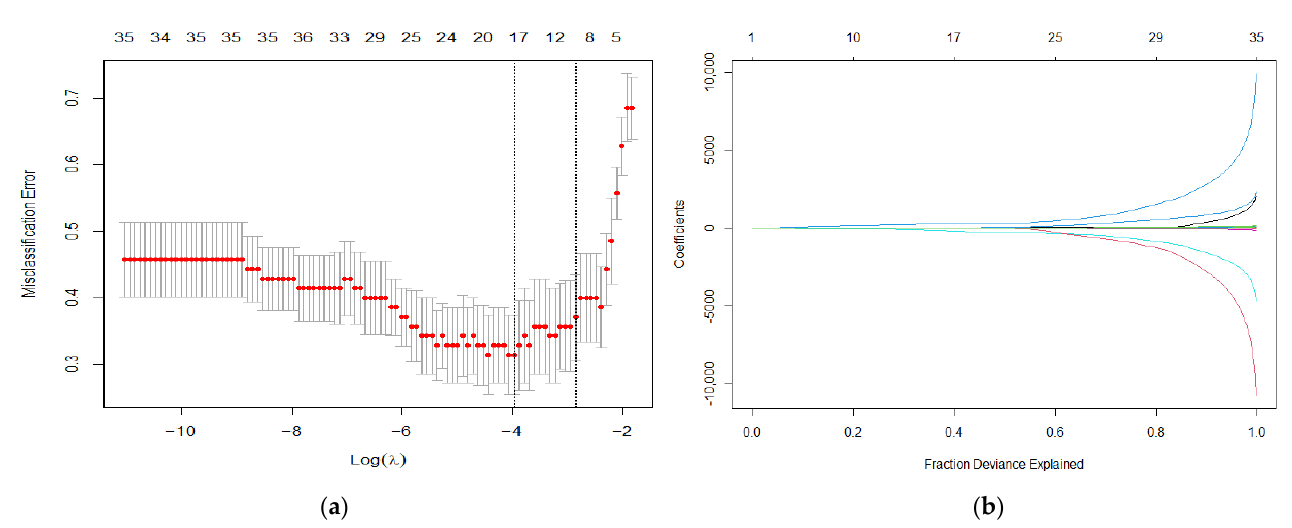
Figure 3. Presentation of the radiomics feature selection. ( a ) Lambda chosen via minimum criteria using 10-fold cross validation; ( b ) fraction deviance explained of the LASSO coefficients. Table 2. Contingency tables of the radiomics model against the ground truth in the training and holdout validation set.